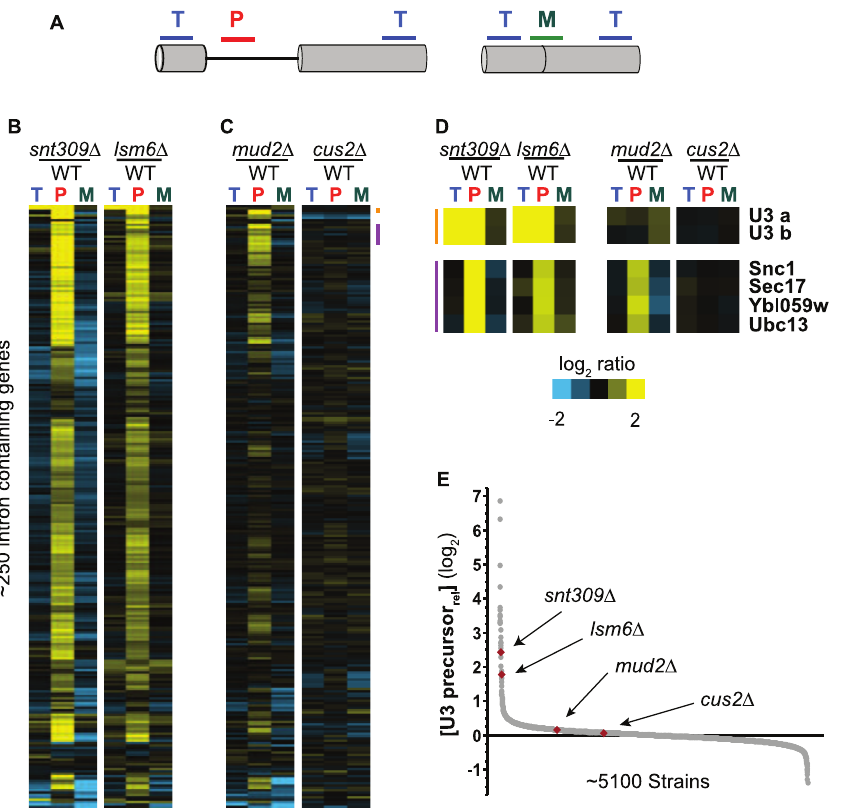
Figure 2. Not all mutations in splicing factors result in defective splicing for all intron-containing genes. A. Splicing-sensitive microarrays contain probes that target precursor (P), mature (M), and total (T) mRNA levels. B. Global splicing profiles of the snt309 D and lsm6 D strains, showing a strong splicing defect for both mutants. C. Global splicing profiles of the mud2 D and cus2 D strains, illustrating different splicing defects for these mutants. Whereas many transcripts show a splicing defect in the mud2 D strain, many continue to be efficiently spliced. Similarly, most intron-containing genes show no splicing defect in the cus2 D strain. D. The behavior of specific transcripts in the different mutant backgrounds. E. Locations within the U3 precursor dataset of the mutant strains for which microarrays are shown in (B) and